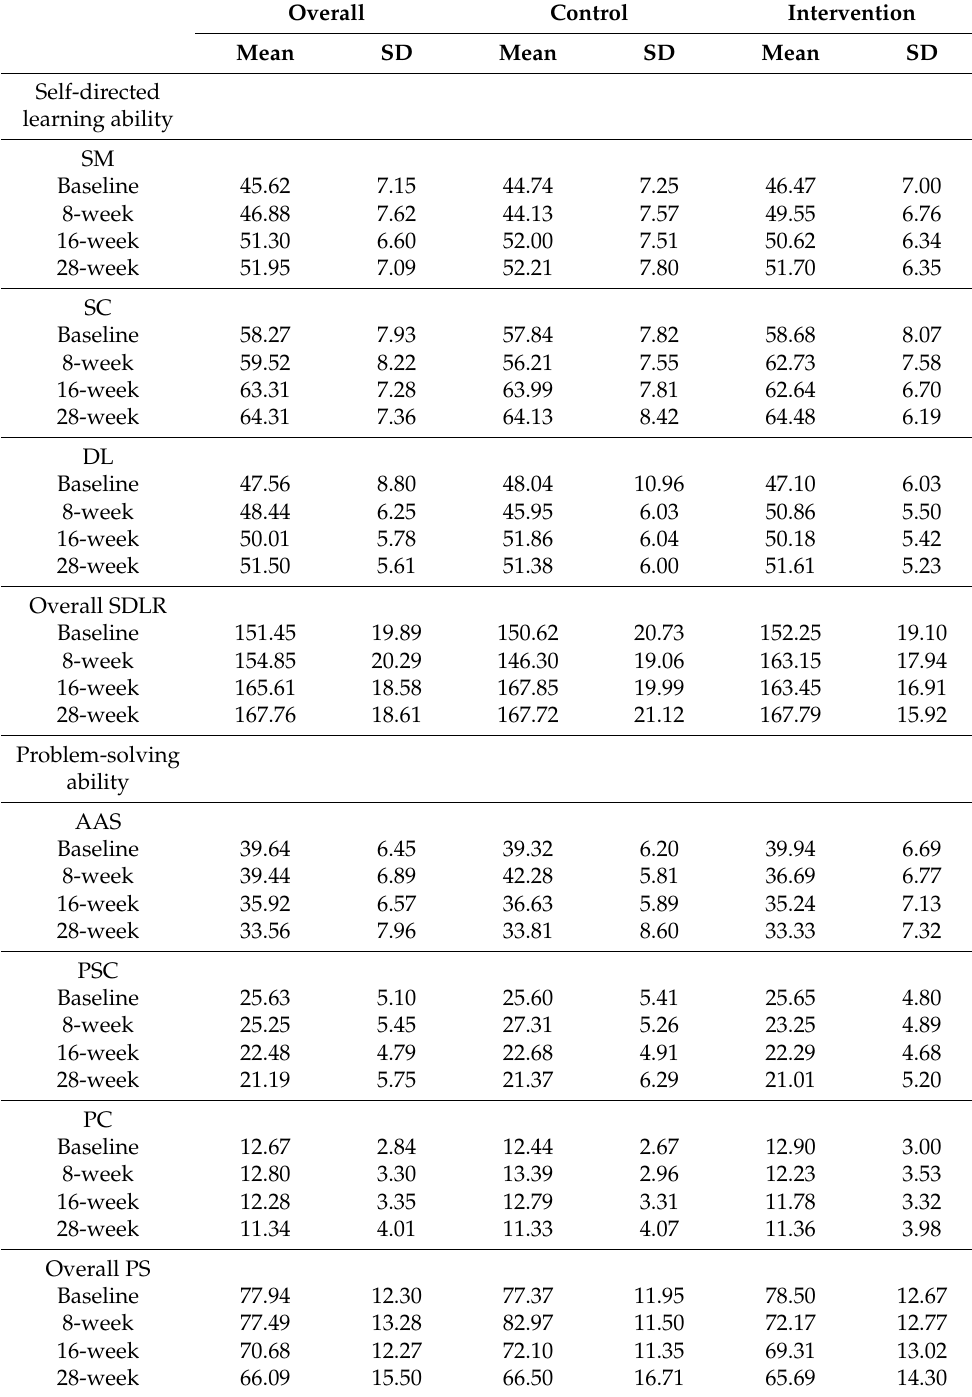
Table 4. Self-directed learning and problem-solving abilities between the two groups at baseline, pre- and post-intervention through small group work. Overall Control